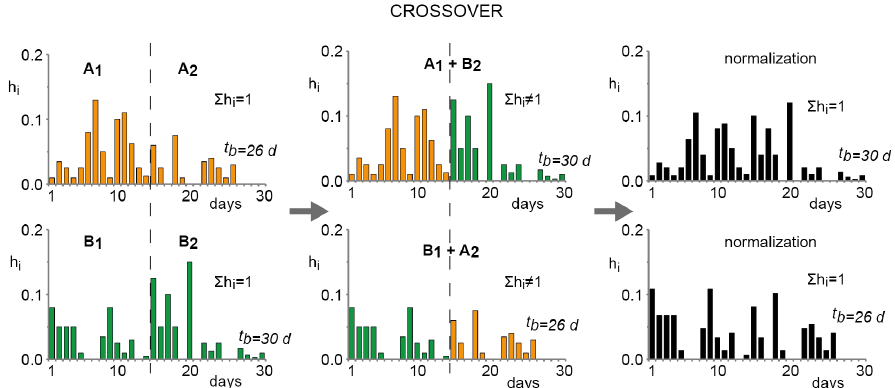
Figure 3. Example of crossover. The genetic codes of the parents (elements in orange and green) are first mixed; then, the children are normalized (black elements) to ensure the validity of Eq.